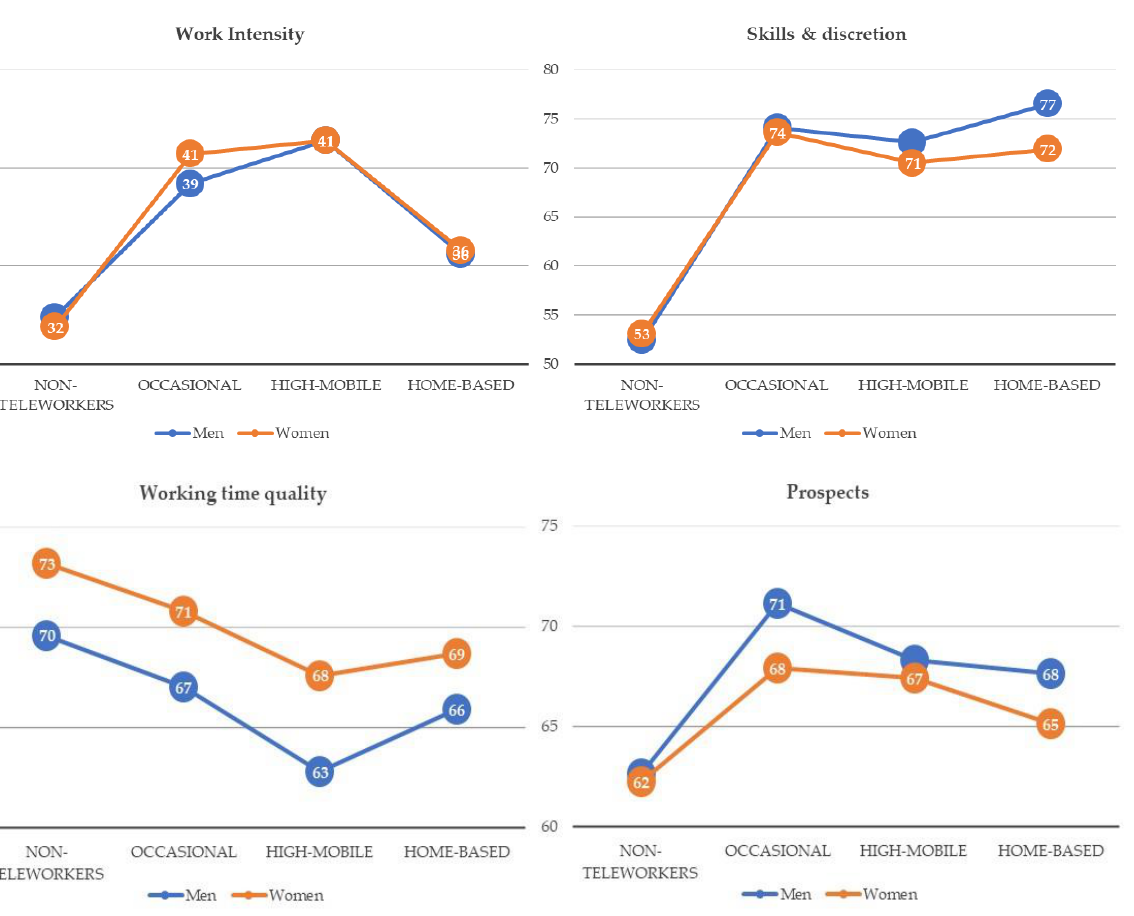
Figure 2. Mean values of the indices by type of telework and gender in the EU28 (weighted). Source: Own elaboration based on Sixth EWCS data.